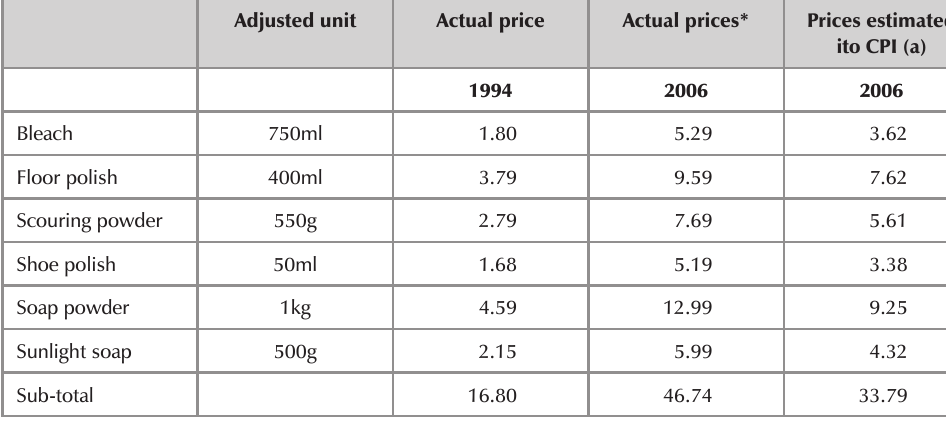
Table 3d Items with prices available from 1994 to